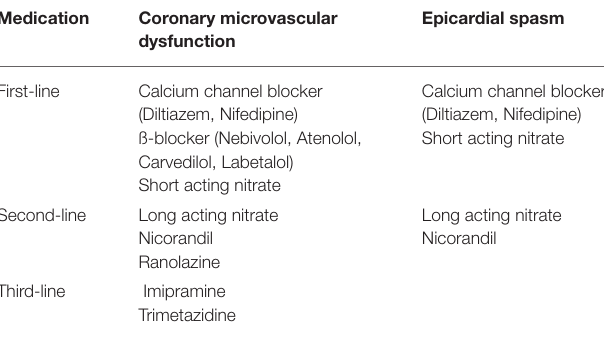
TABLE 4 | Anti-anginal treatment for CMD and epicardial